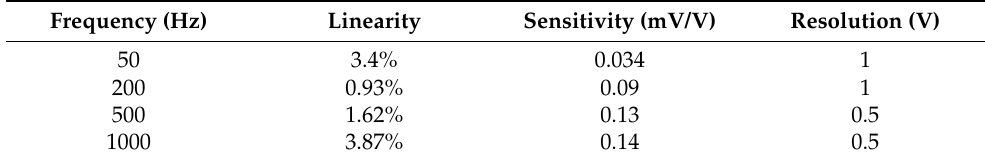
Table 2. The linearity, sensitivity, and resolution of the sensor.